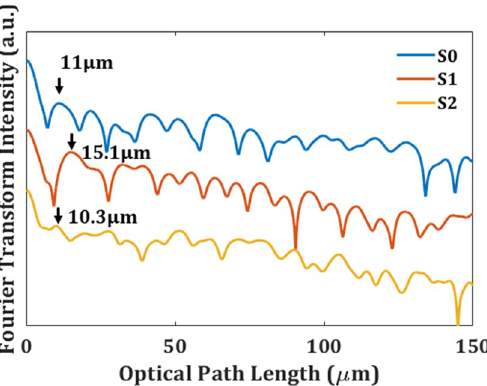
Figure 4. Fourier transform spectra versus optical path length of Turquoise-Fronted Amazon yellow-green feather S0, dark-green feather S1, and red feather S2.